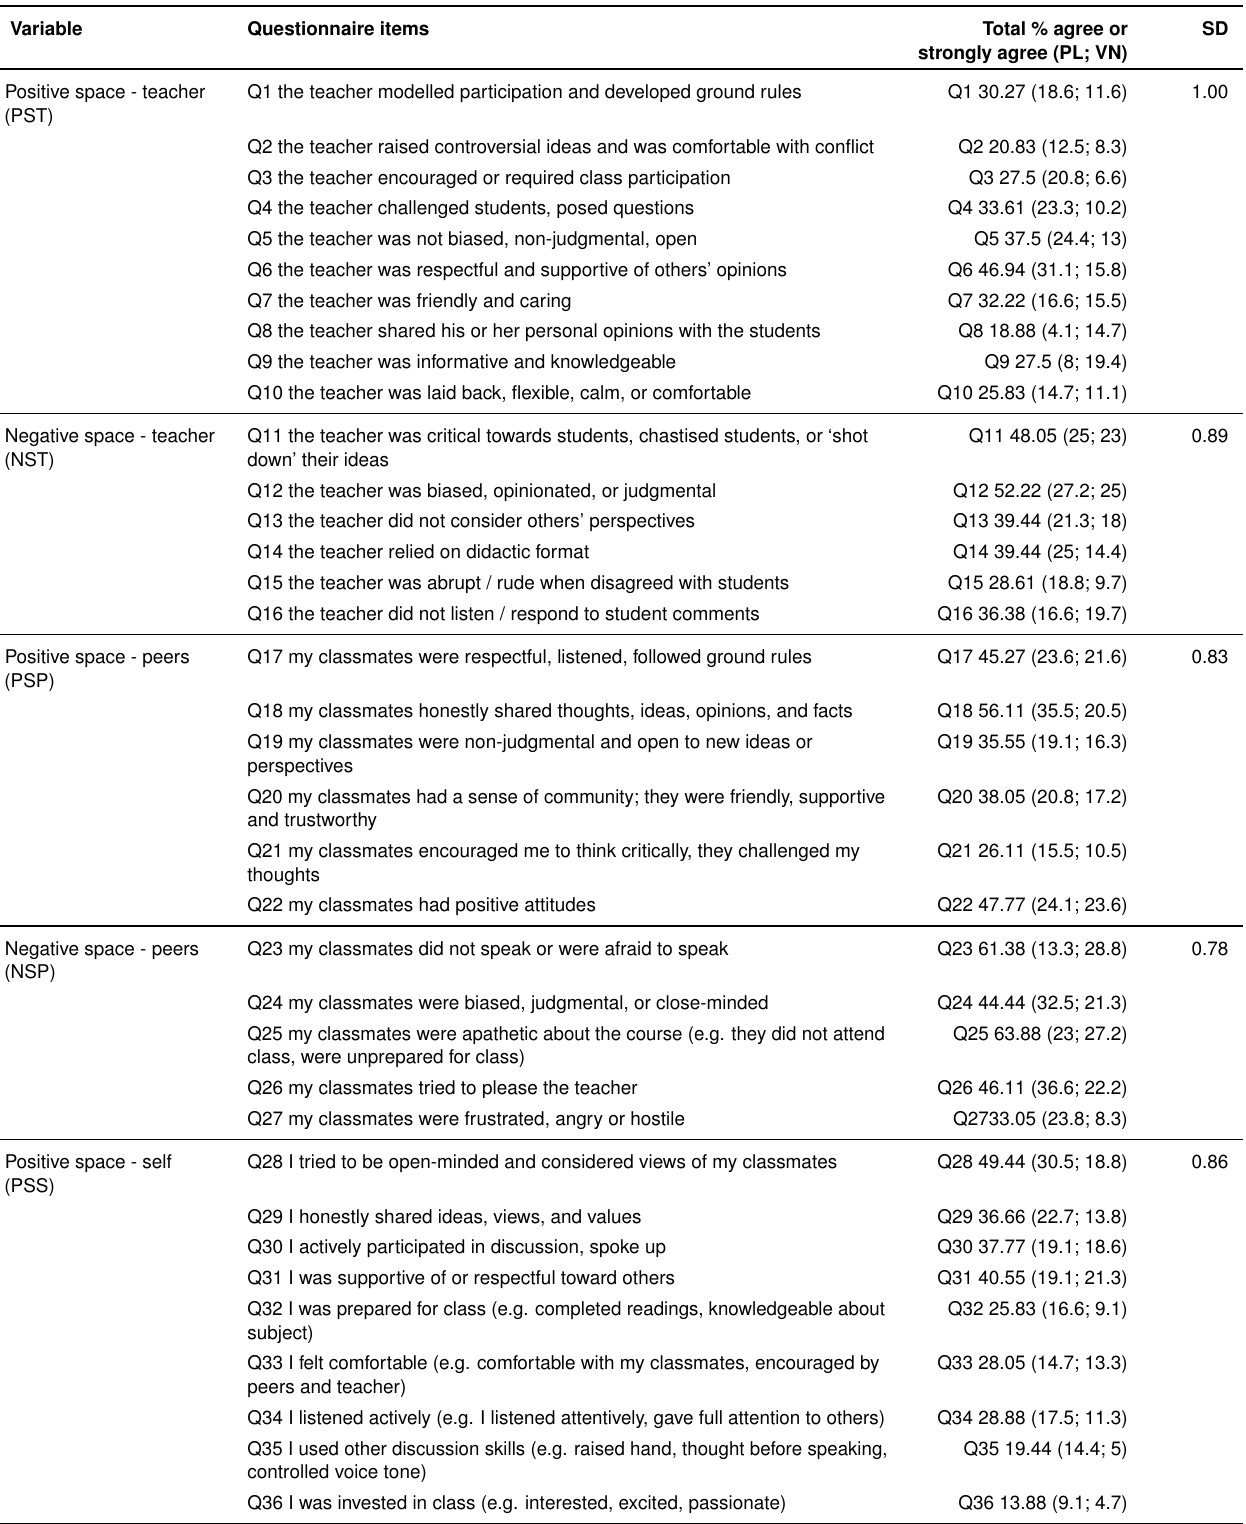
Table A1. Descriptive statistics of the study variables in the answers given by Polish [PL] and Vietnamese [VN] students.